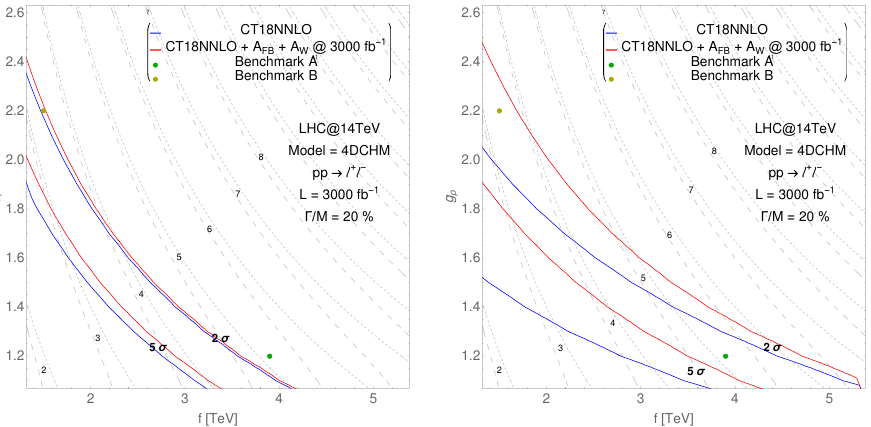
Figure 3 . Exclusion and discovery limits at 3000 fb − 1 for the peak (left) and for the dip (right) for Z 0 resonances with Γ /M = 20%. The short (long) dashed contours give the boson mass M Z ( M Z ’ M W ) in 3 2